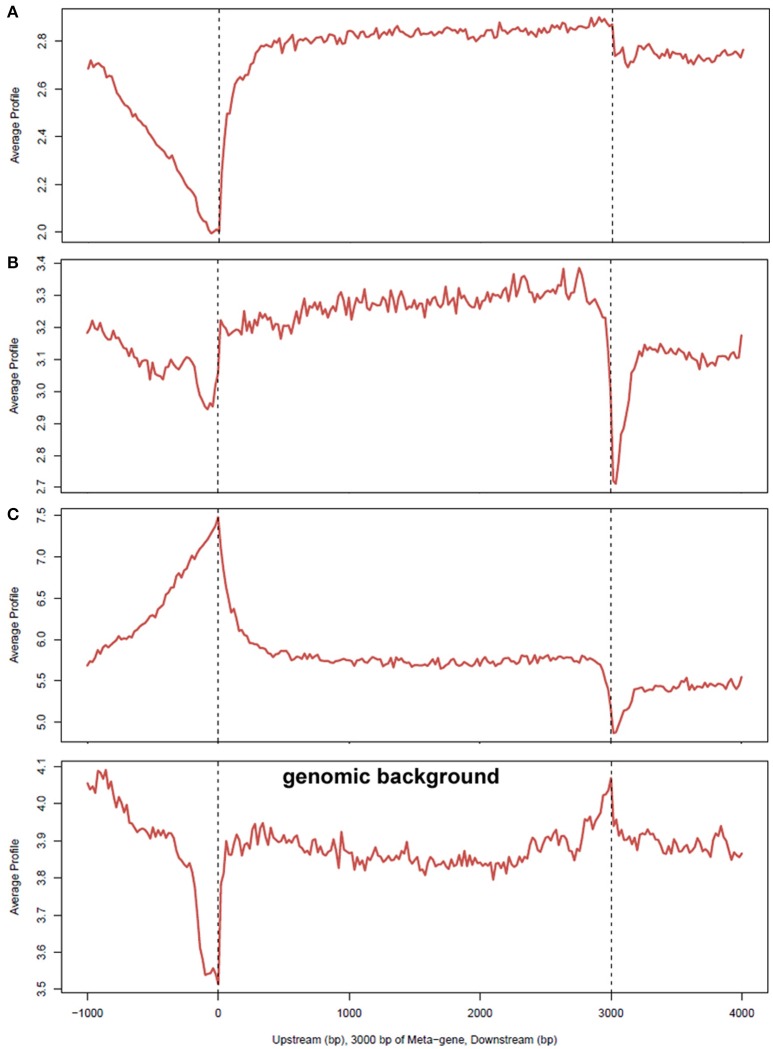
Average profiles of AnkA binding enrichment over gene bodies normalized to 3000 bp, including upstream and downstream region. The average signal profiles for AnkA binding at the upstream (left), gene body, and downstream (right) regions of genes, normalized to a 3000 bp gene is shown; (A–C) represent the data from the 3 individual neutrophil DNA samples used; genomic background is shown to demonstrate relative enrichment compared to mappable regions in the data sets. A reduction in AnkA enrichment was observed in 2 of 3 samples at and prior to the TSS and upstream. One sample showed a markedly different profile in this region, but all 3 samples were enriched in this region compared to genomic background. This patterns suggests a variable preference for AnkA enrichment at TSSs, but at lower levels than in adjacent gene bodies, or upstream or downstream regions. While all samples had a relatively level enrichment throughout the gene body, enrichment dropped at the TTS compared to the genomic background indicating that AnkA is largely excluded from these regions. AnkA enrichment returned to slightly lower levels than in gene bodies further downstream.